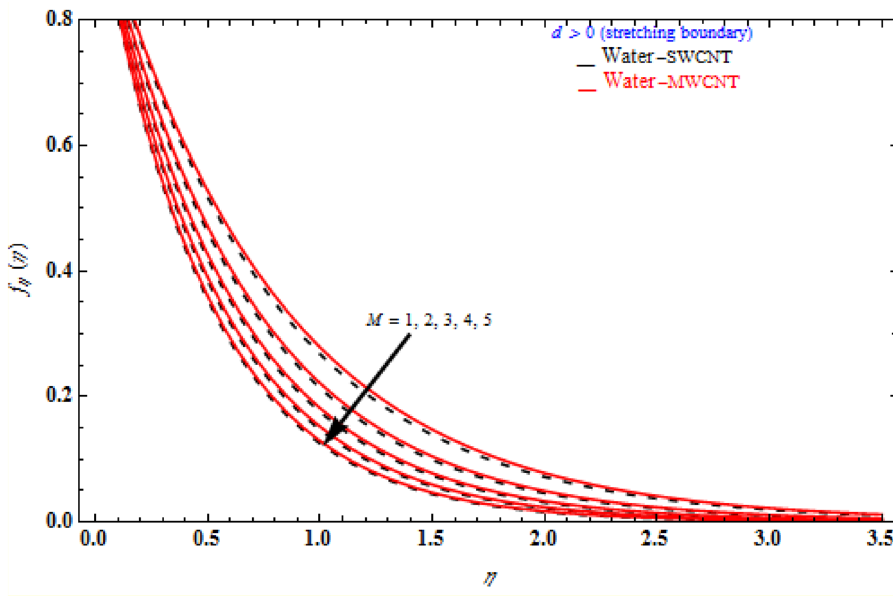
Figure 6. Impact of M on axial velocity with k 1 = 1, Da -1 = 1, τ = 90° for stretching case.